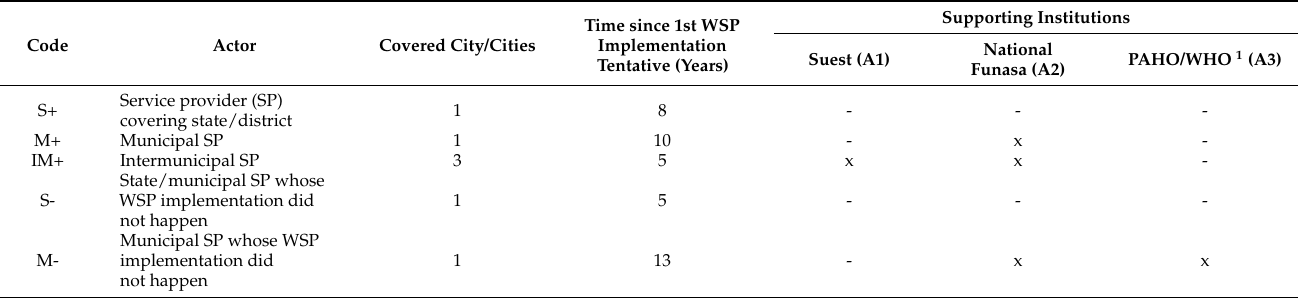
Table 2. Interviewed actors, codification attributed to the interviewees, and supporting